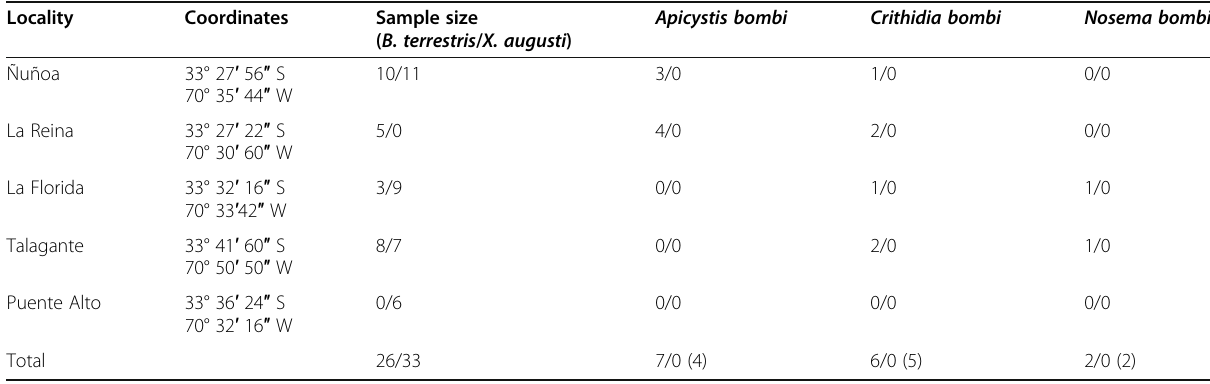
Table 1 Number of individuals screened and infected with each parasite per site and bee species. The number of PCR products sequenced is indicated in parenthesis Locality Sample size ( B. terrestris / X. augusti